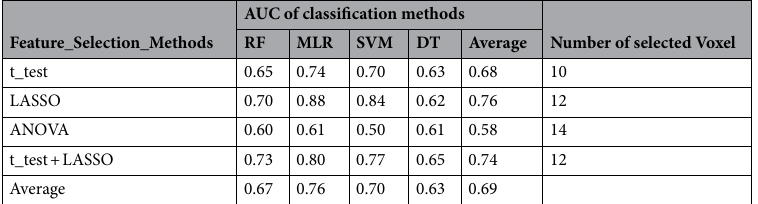
Table 2. Number of features extracted by different feature extraction methods and the average